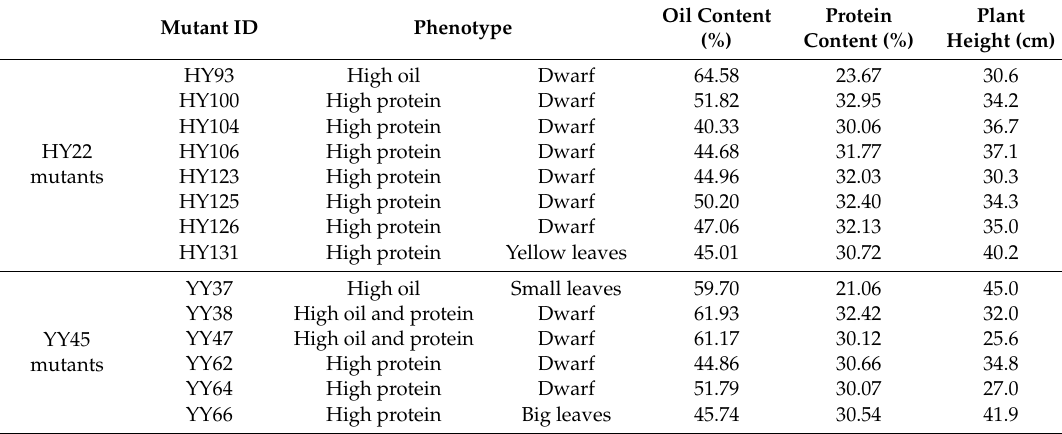
Table 1. Mutants related to high oil and/or protein of HY22 and YY45 induced by EMS treatment. Mutant Mutant